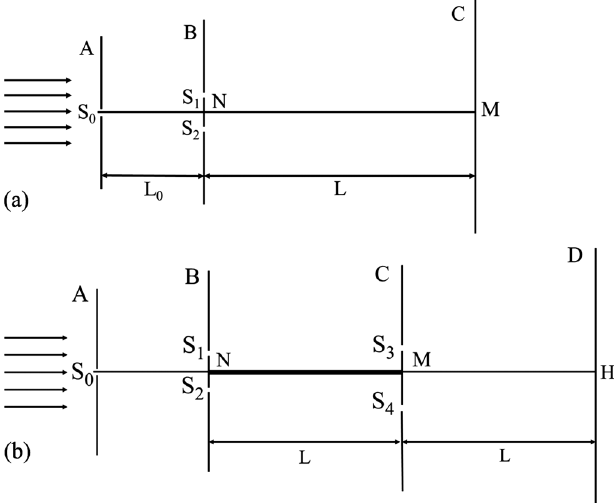
FIG. 6. (a) Q5 and Q6 problem setup. (b) Q7 and Q8 problem setup. In part(b), there is a barrier placed in between the first and second set of slits that blocks light from S 1 from entering S 4 and light from S 2 from entering S 3